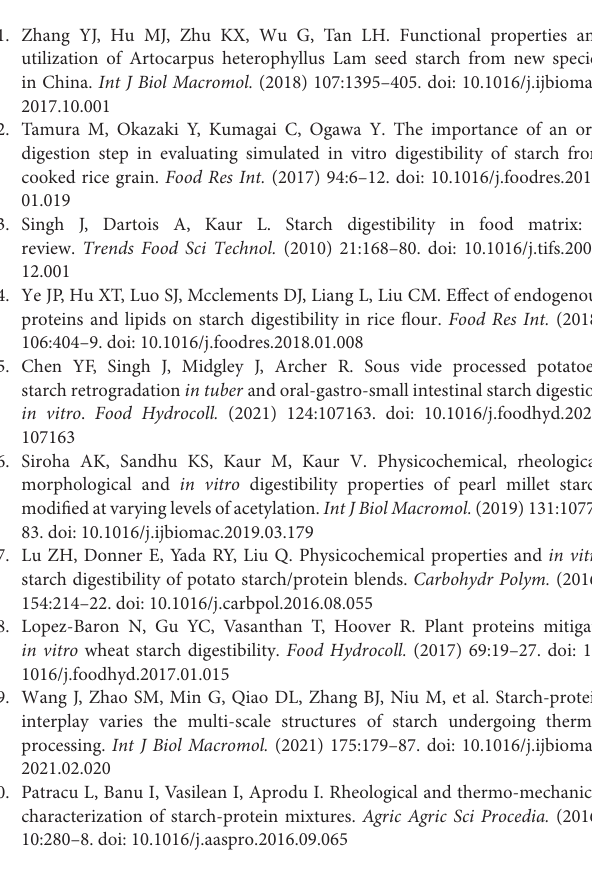
times (0, 1, and 2 h). Supplementary Table 9 | Data sheet of the pertinent parameter of in vitro digestibility of native corn starch and core-shell starch/zein microparticles crosslinked by TGase for different